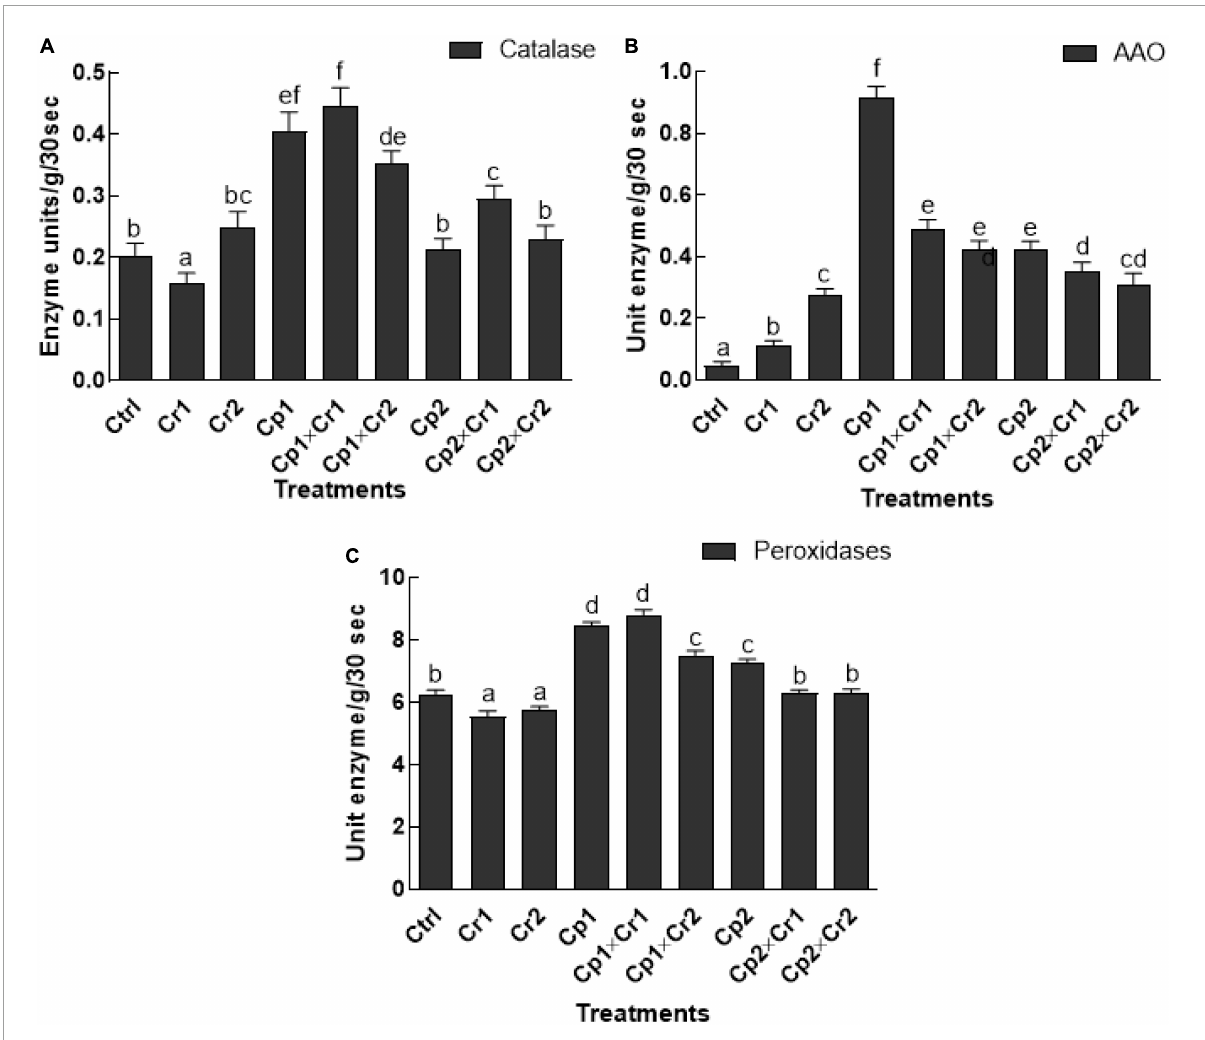
FIGURE4 (A) Catalase (CAT); (B) Ascorbic acid oxidase (AAO); (C) Peroxidase. In vitro studies on the effect of isolate Cp1 and Cp2 on stress-related enzymes of soybean seedlings exposed to chromate stress. Cp1 = Stemphylium lycopersici ; Cp2 = Stemphylium solani ; Ctrl =